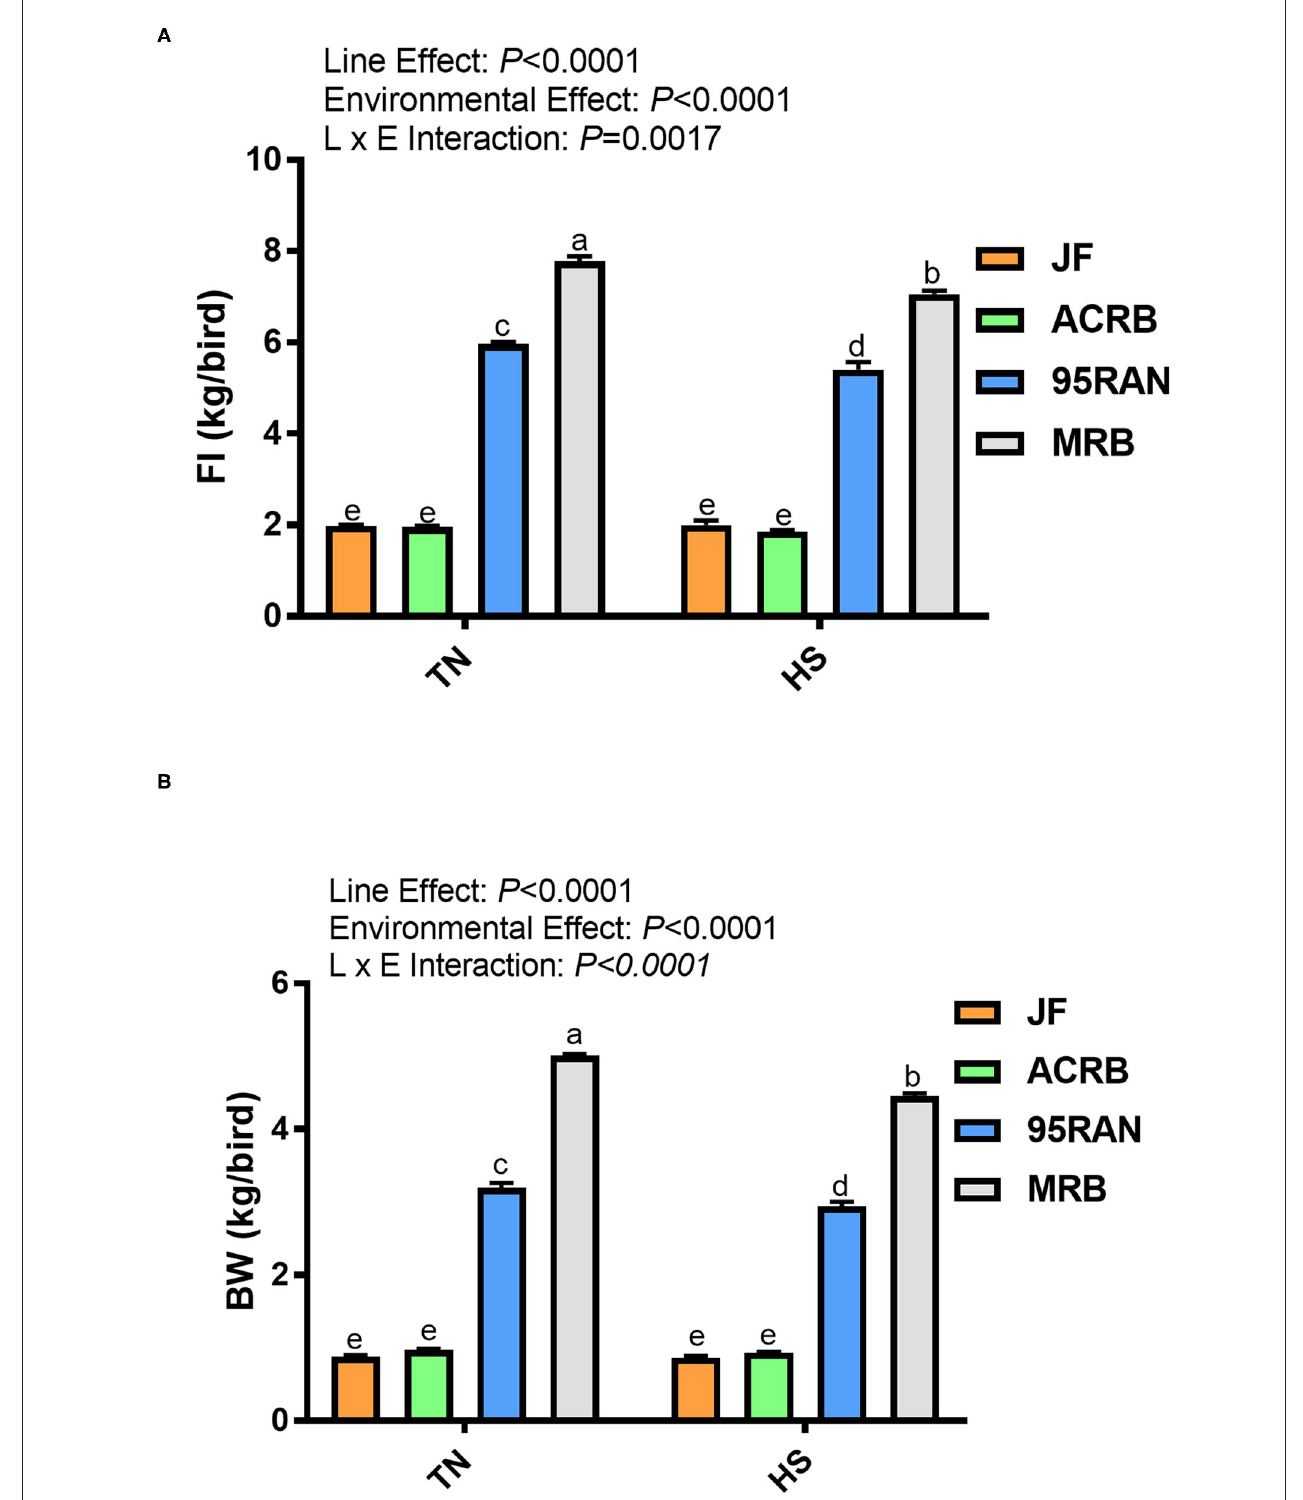
FIGURE 1 | Effect of HS on feed intake (A) and body weight (B) of JF, ACRB, 95RAN, and MRB birds. Data are mean ± SEM ( n = 3 pens/group for FI and n = 75 birds/group for BW). Different letters indicate a significant difference at P < 0.05. BW, body weight; FI, feed intake; HS, heat stress; TN, thermoneutral; JF, jungle fowl; ACRB, Athens Canadian Random Bred; 95RAN, 1995 random bred; MRB, modern random bred.